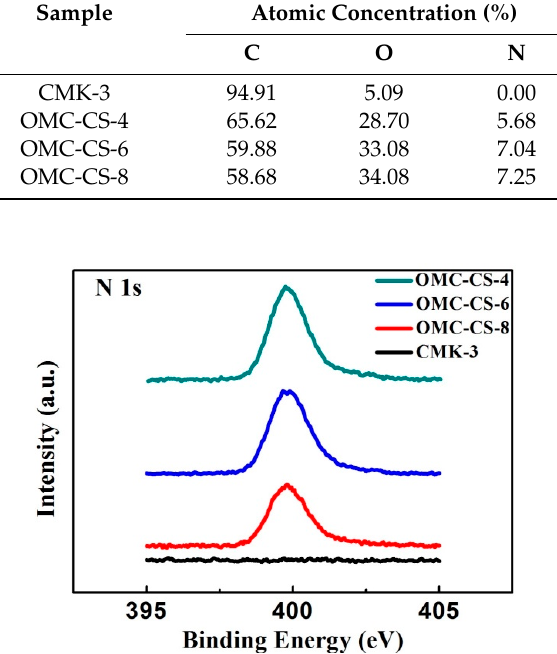
Figure 5. N 1s spectra of CMK-3 and OMC-4,6,8.